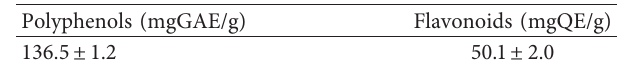
Table 4: Polyphenol and flavonoid content of Origanum grosii